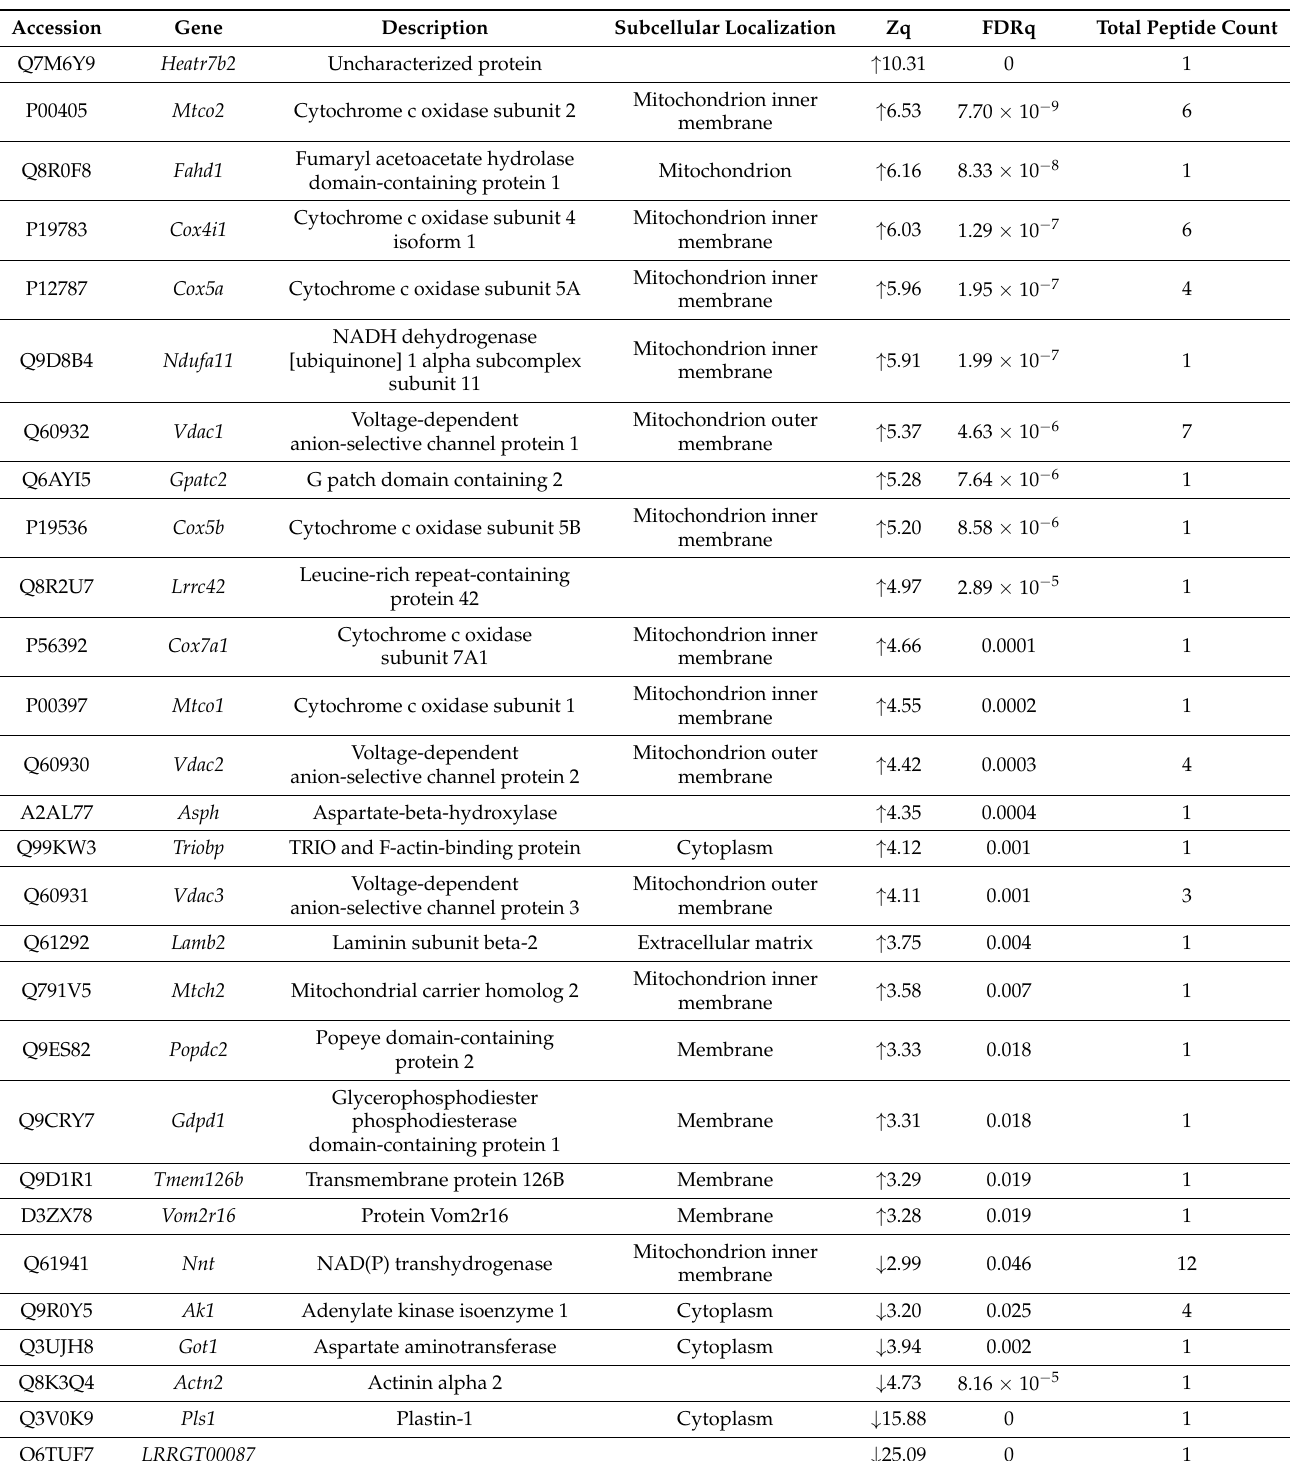
Table 1. Differentially regulated proteins in response to cyclooxygenase-2 constitutive expression sorted according to fold change. Standardized variable at the protein level was calculated as previ- ously described